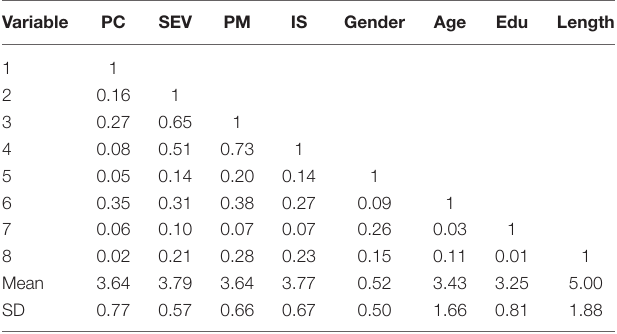
TABLE 1 | Means, standard deviations, and correlations ( N = 279). Variable